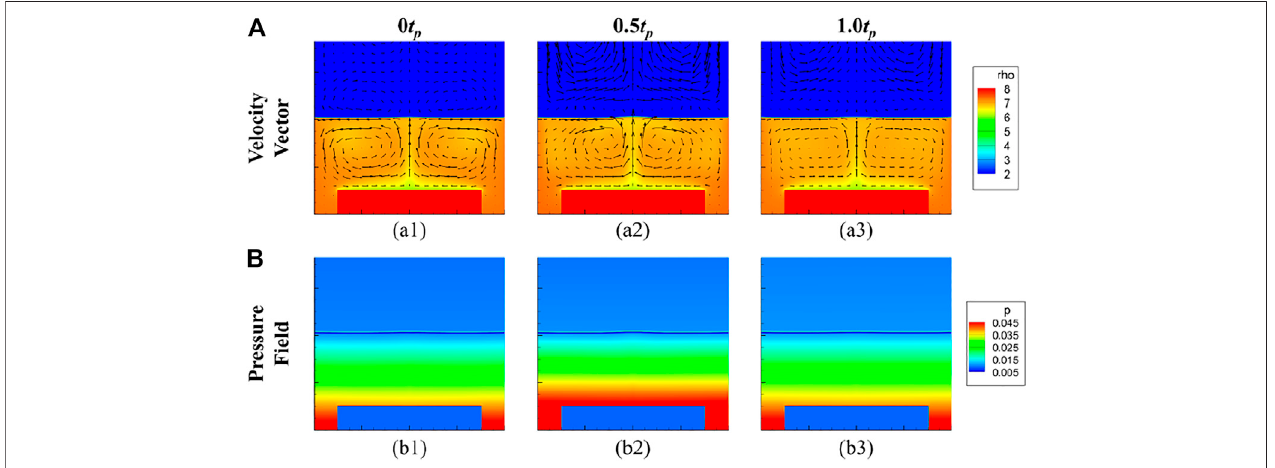
FIGURE 9 | Velocity vector and pressure fi eld at the convection regime under heaving conditions.